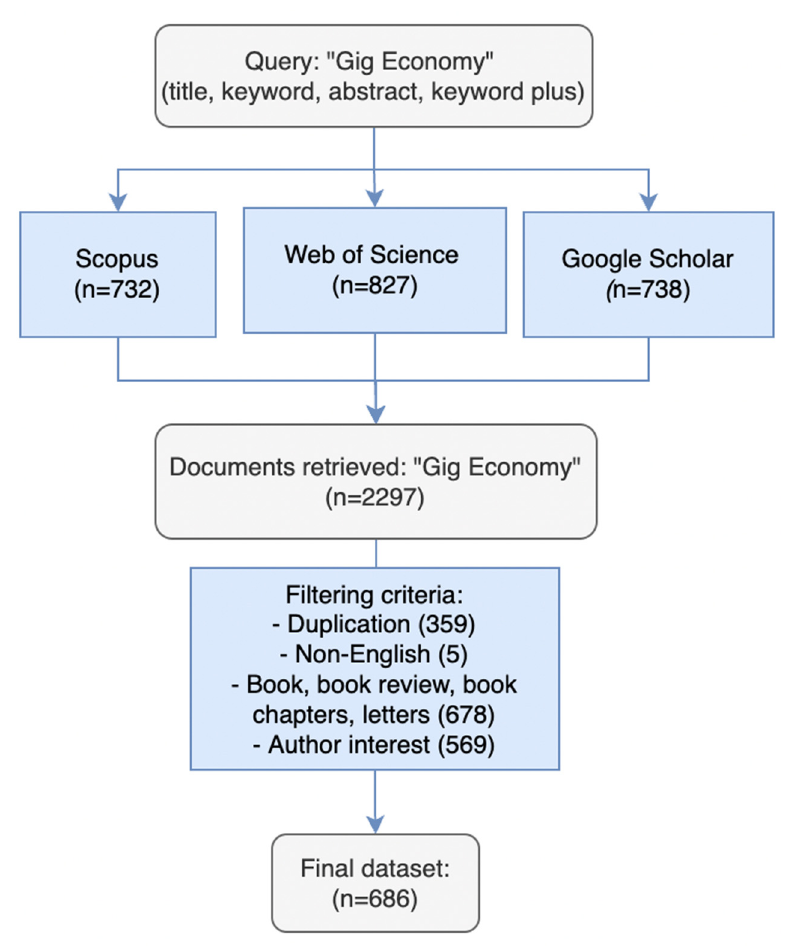
Figure 1. Article selection process.